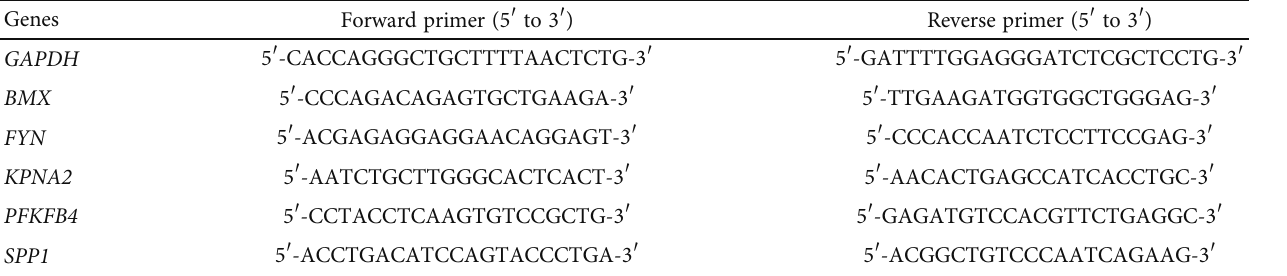
Table 2: Primers used for